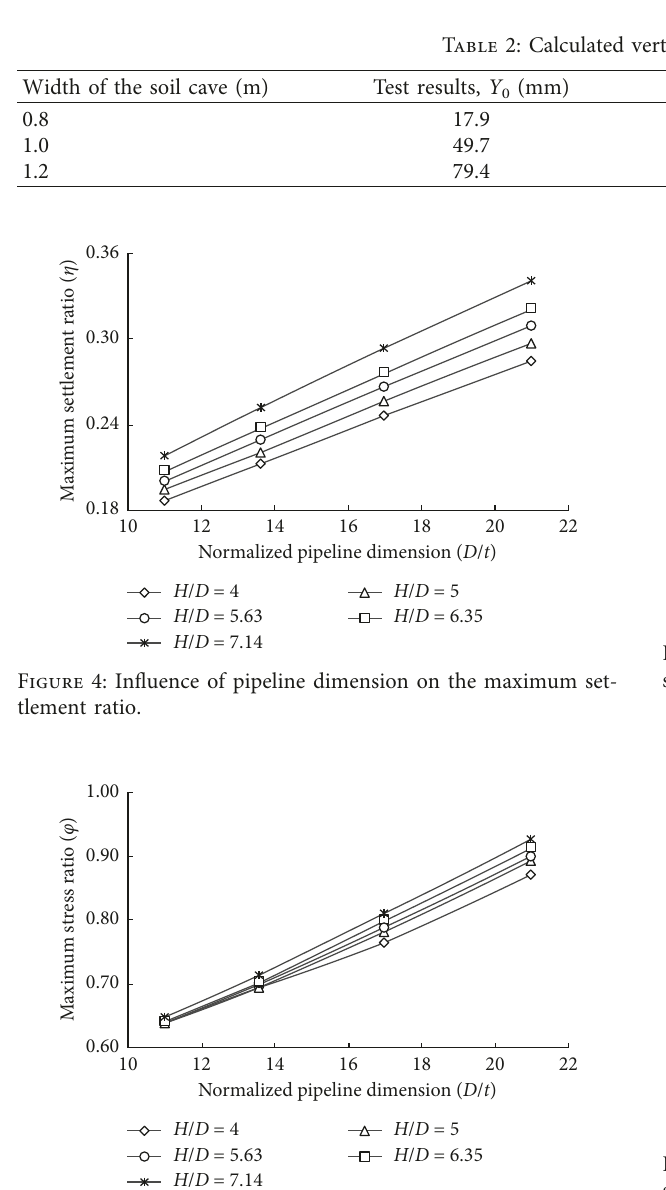
Figure 5: Influence of pipeline dimension on the maximum stress ratio.